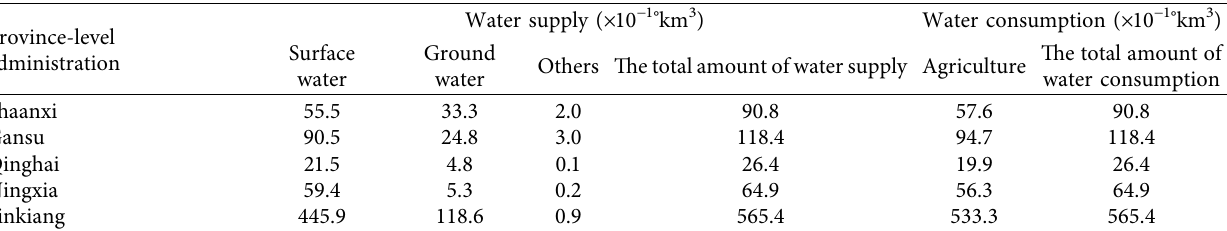
Table 1: Water supply and water consumption of five provinces and autonomous regions in northwest China in 2016. Province-level